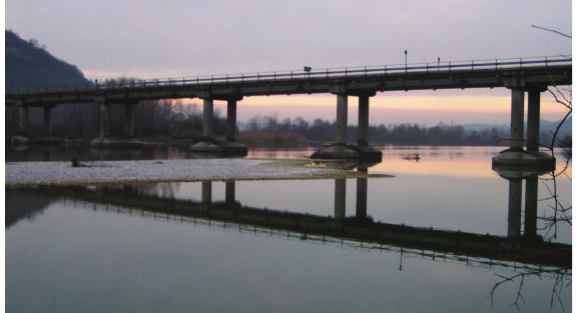
Figure 1: Fener bridge: (a) lateral view of the bridge on the Piave